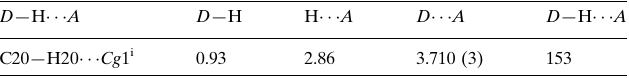
Hydrogen-bond geometry (A˚ , (cid:1)